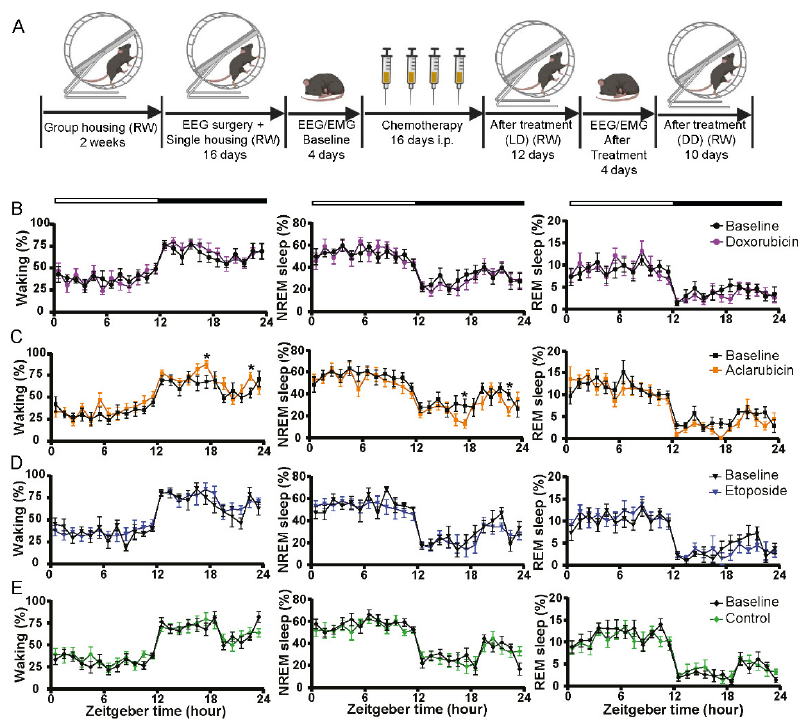
Figure 3. Chemotherapy-induced fatigue is not caused by changes in the sleep-wake rhythm. ( A ) Experimental design of the sleep–wake study. EEG—electroencephalogram, EMG—electromyography, RW—running wheel, LD—light-dark, DD—constant dark. ( B – E ) One-hour values of Waking, NREM, and REM sleep of 24 h before treatment baseline day compared with doxorubicin ( B ), aclarubicin ( C ), etoposide ( D ), and control ( E ) treatment. Values are shown as mean ± SEM. control n = 9, doxorubicin n = 8, aclarubicin n = 8, etoposide n = 7. Two-way ANOVA with Bonferroni multiple comparisons, compared with time-matched control values; * p < 0.05. White and black bars at the top indicate the light–dark cycle.